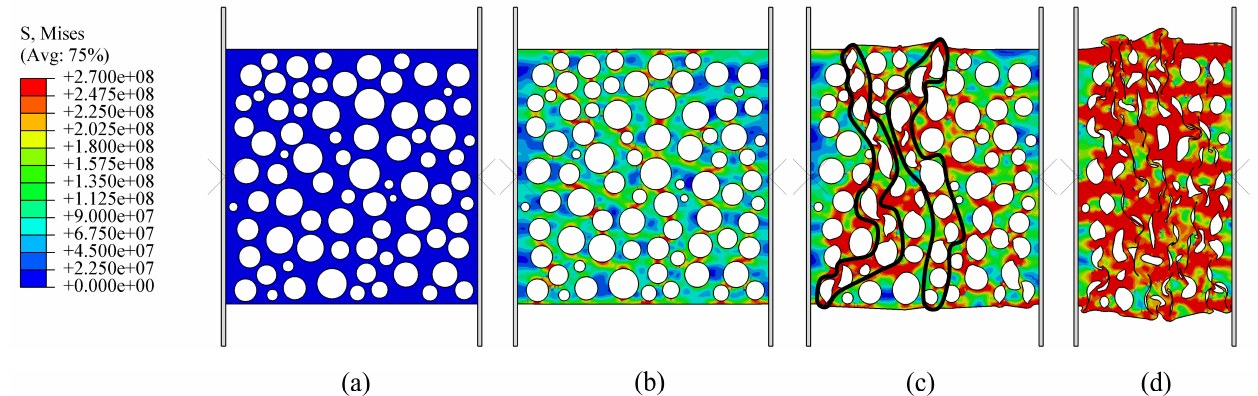
Figure 3. Porous copper–aluminum alloy compression process diagram, where ( a ) is the initial state, ( b ) is entering the plateau region, ( c ) is the plateau region, and ( d ) is the densification region. The calculated nominal stress-strain curve of the porous aluminum alloy is shown in Figure 4. The strain rate effect of the material is not considered in the calculation. It can be seen from Figure 4 that the stress-strain curve of porous metal shows three regions: the elastic region, plateau region, and densification region when it is compressed.